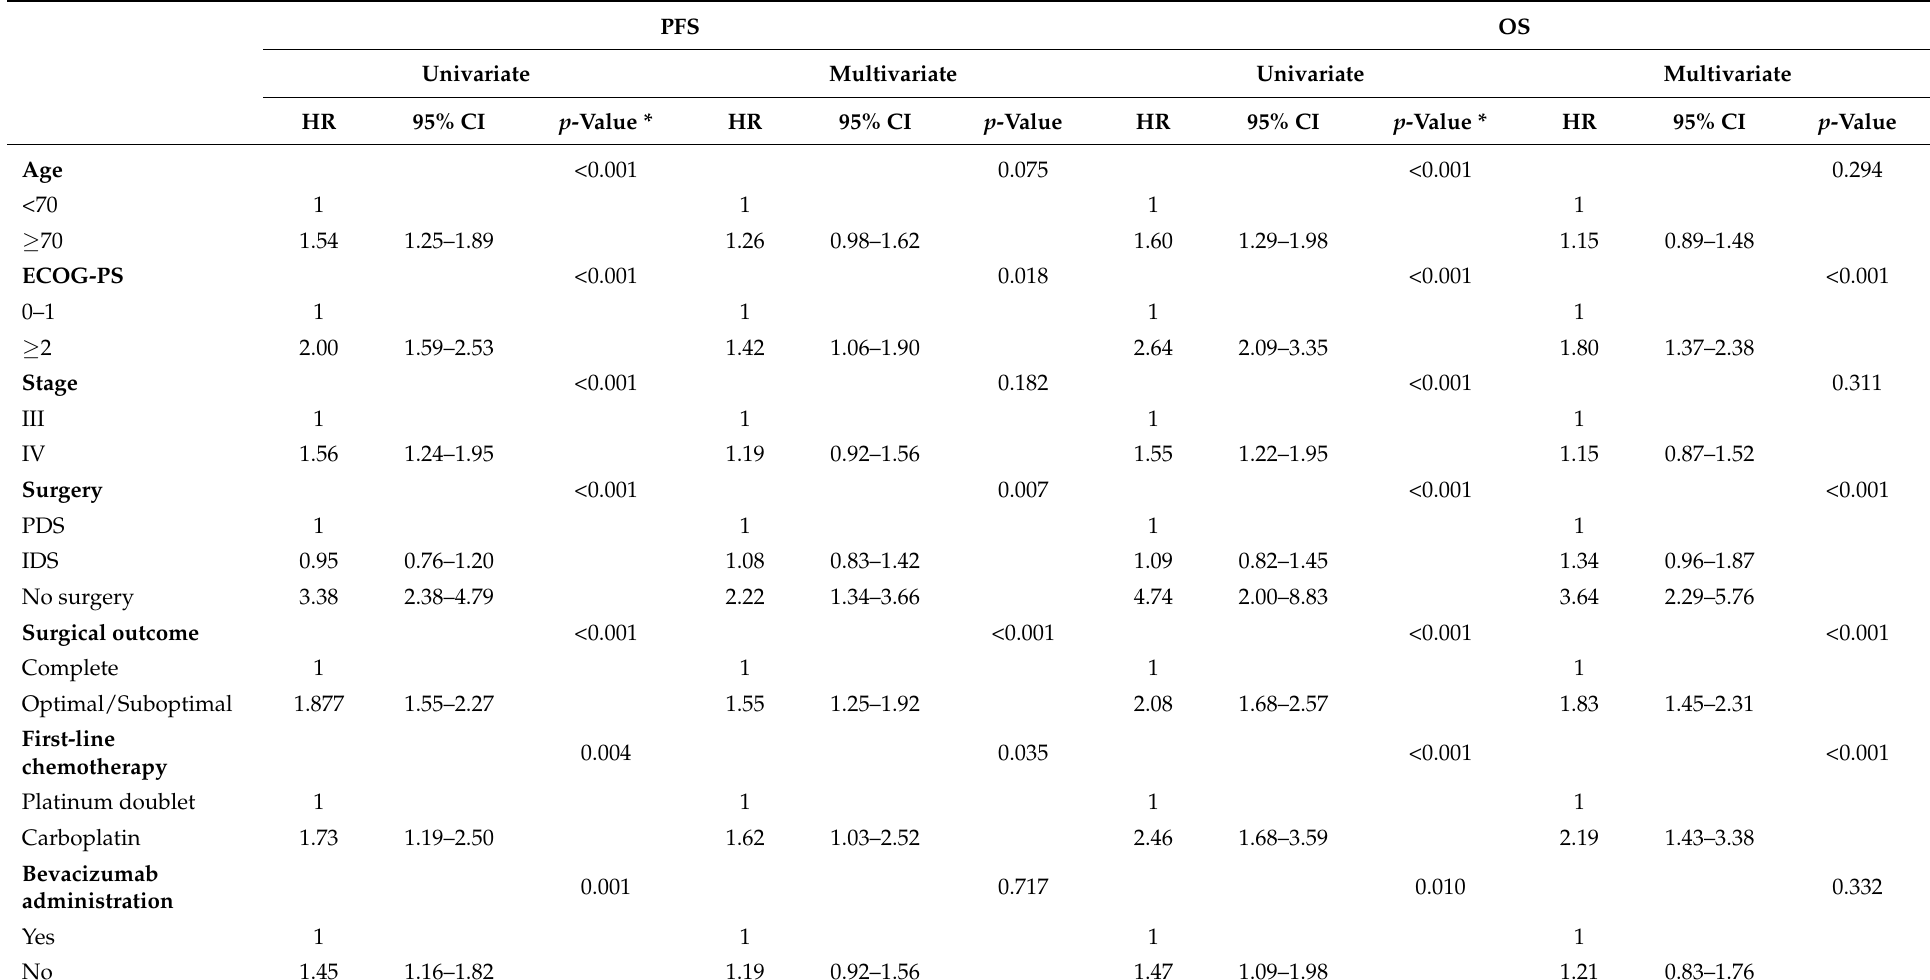
Table 2. Univariate and multivariate Cox-regression analysis for PFS and